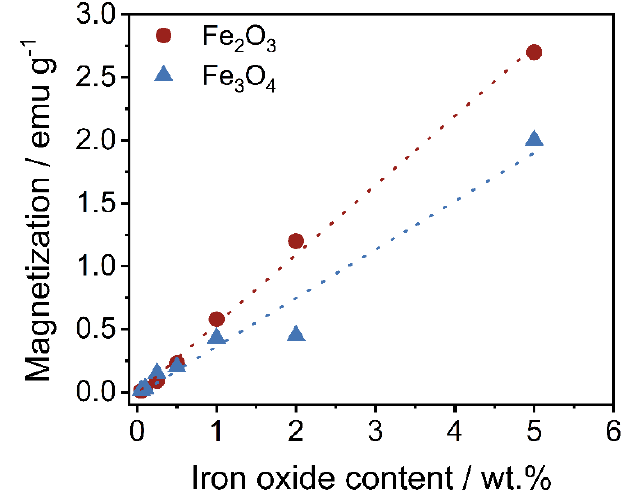
Figure 10. Relationship between the maximum magnetization as regards the set iron oxide content.